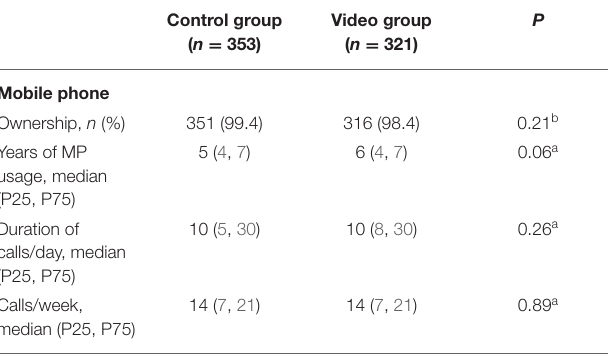
TABLE 2 | MP usage for control group and video group ( n =